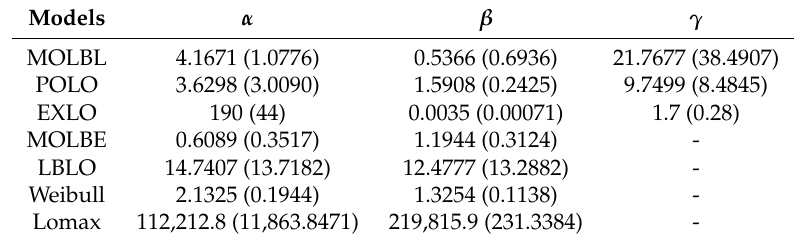
Table 9. Estimates and standard errors (in parentheses) of the parameters for Data set 2.